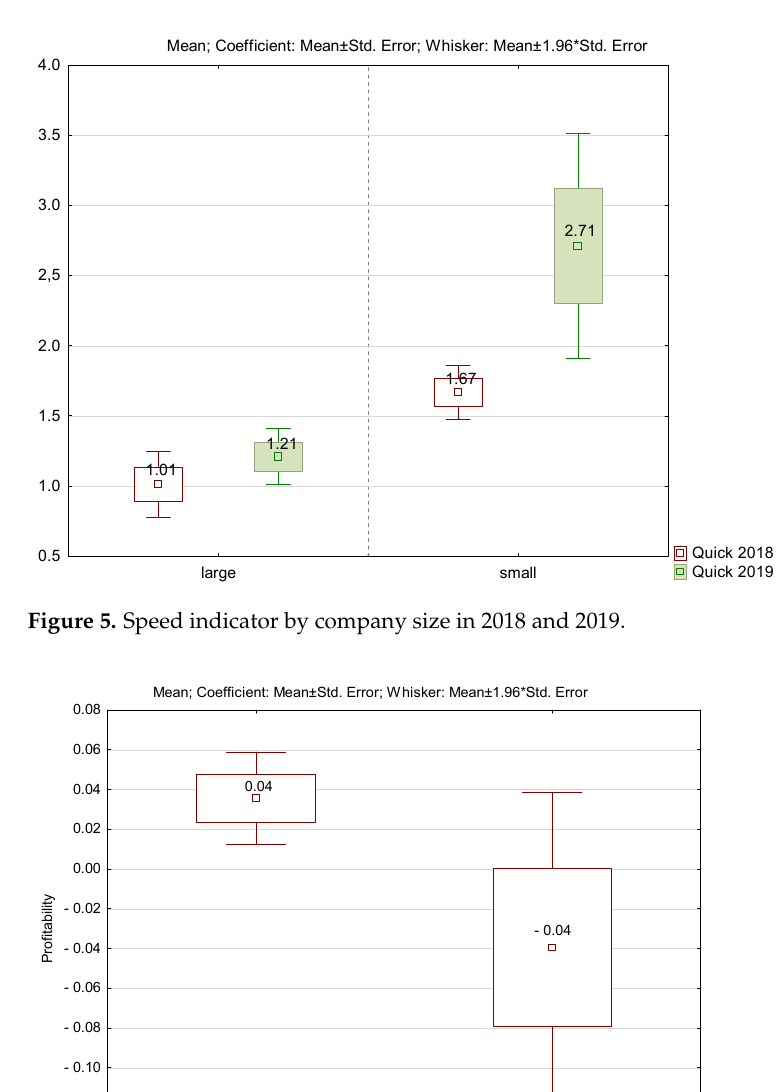
0.18 Figure 4. Share of short-term receivables in current assets in 2017 in relation to the company’s size.